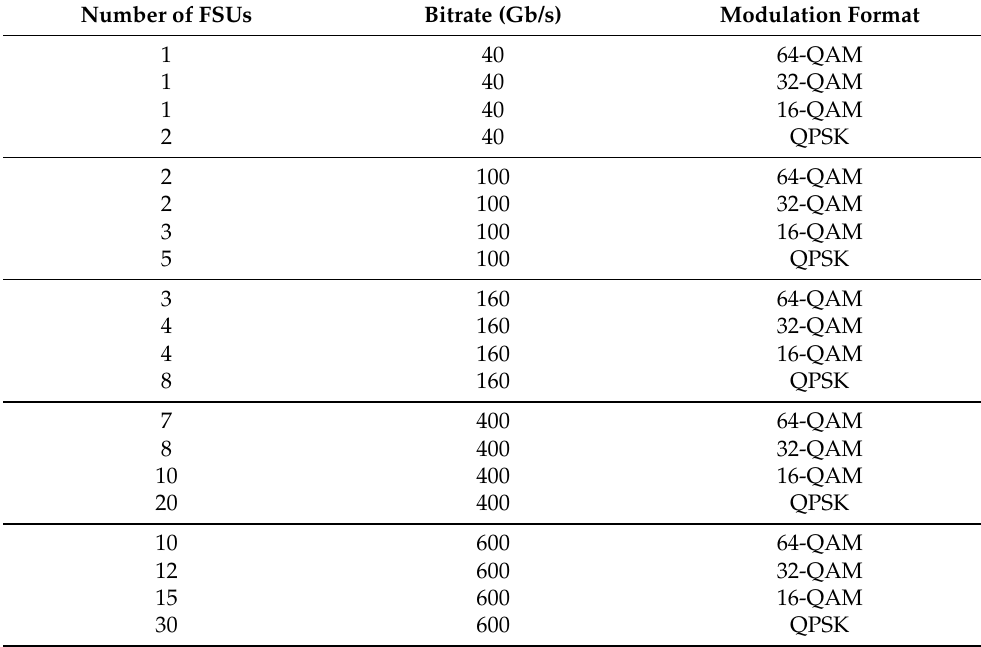
Table 2. Number of FSUs in different connections depending on required bitrate and modulation format